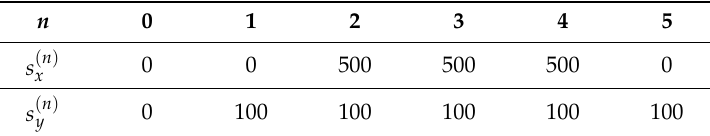
Figure 13. Points of foot placement. Table 1. Foot position data.